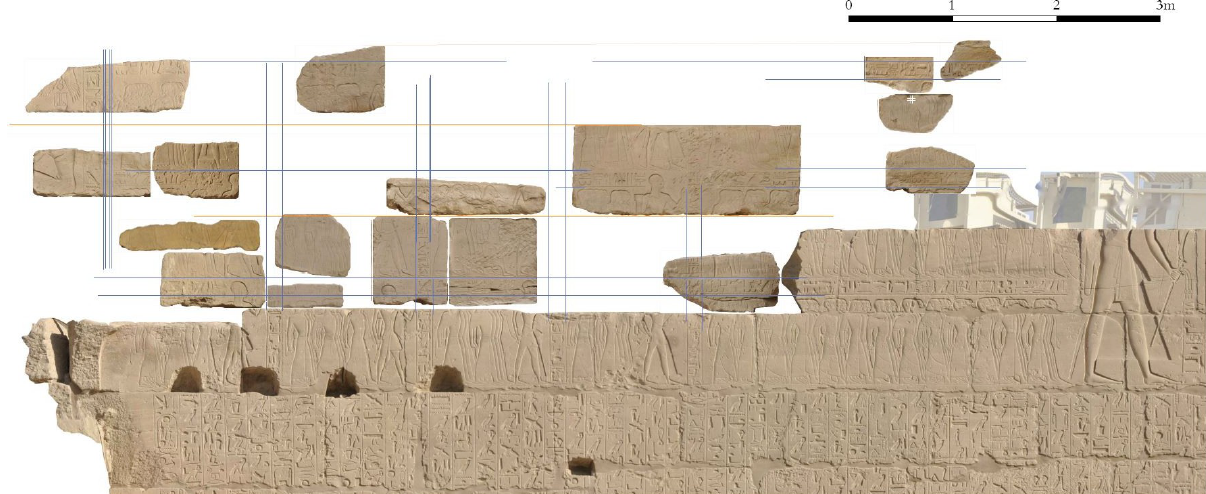
Figure 4: Assembly test scaled on the 12m high wall top part with orthophotographs of recently discovered blocks (Cachette Courtyard North Wall, ongoing